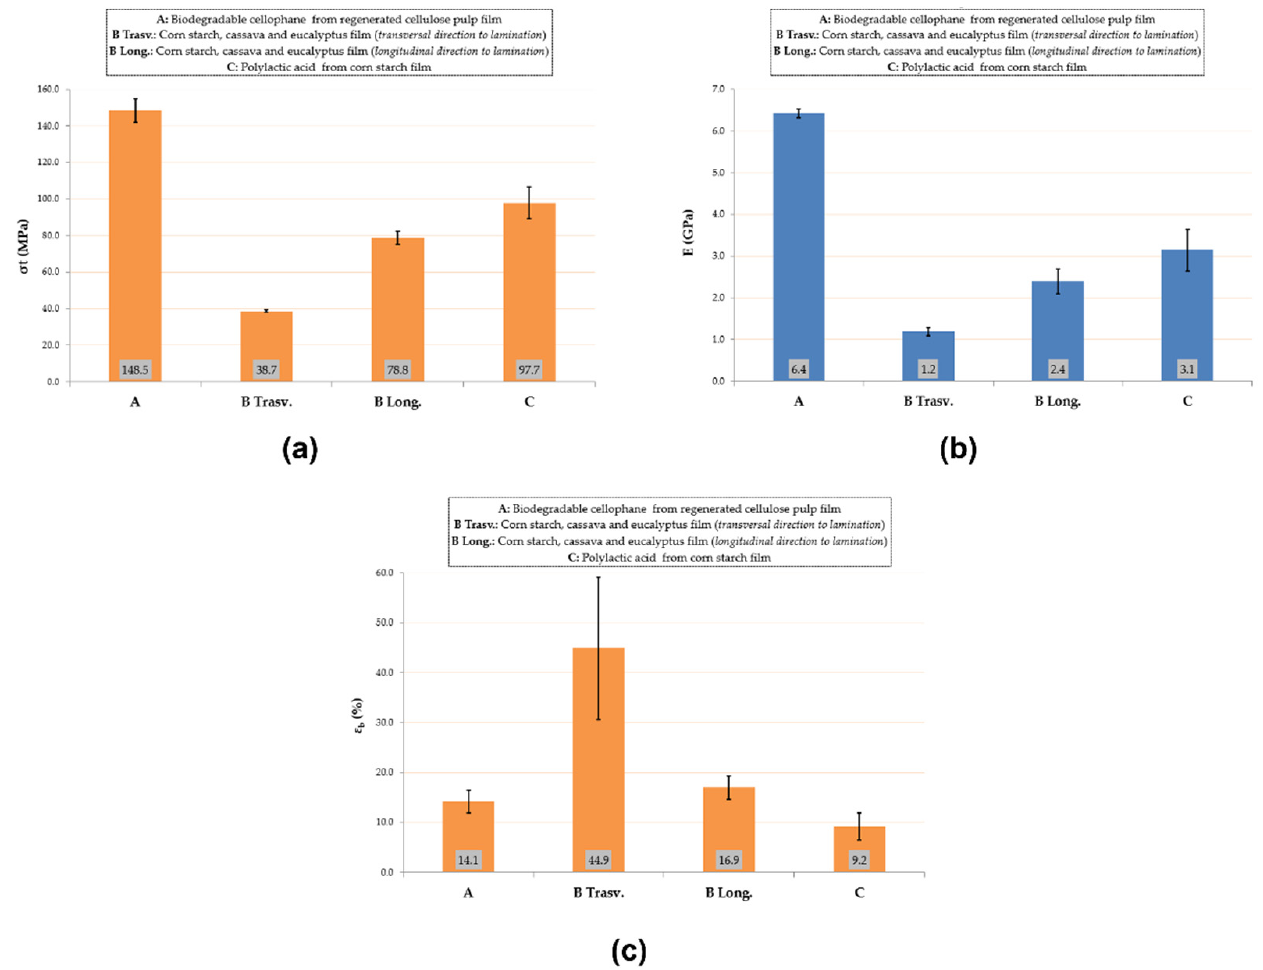
Figure 3. Tensile test results: tensile strength ( a ), elastic modulus ( b ), and elongation-at-break ( c ).